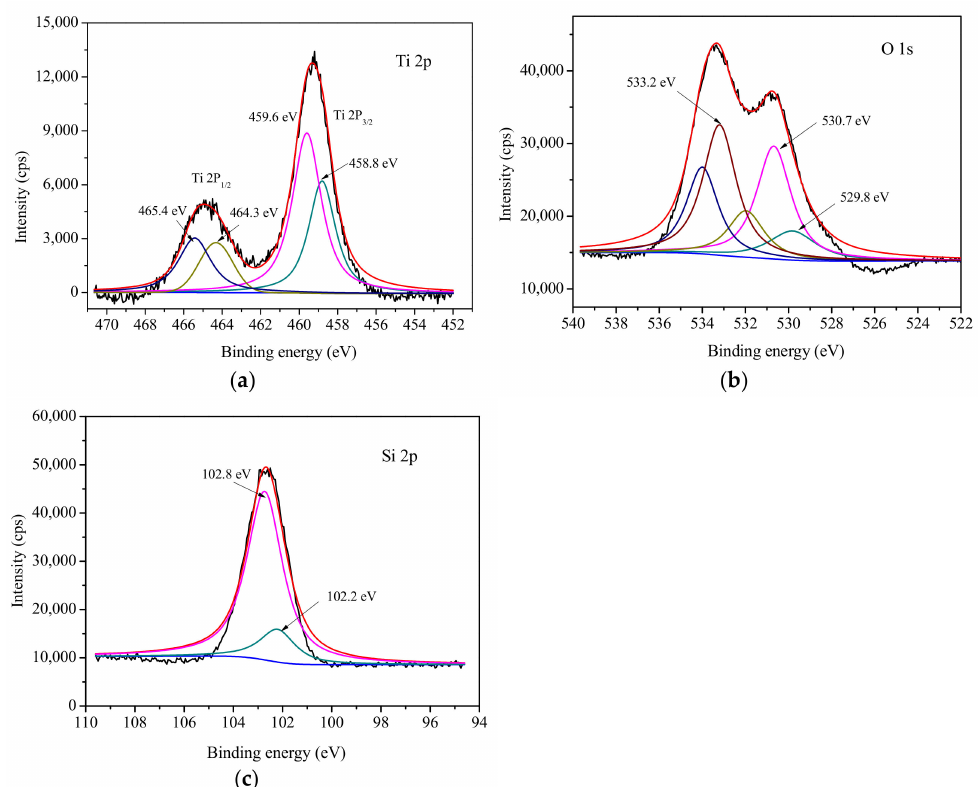
Figure 4. High-resolution XPS spectra of the Ba/TiO 2 –MCM-41composite for Ti 2p ( a ), O 1s ( b ), and Si 2p ( c